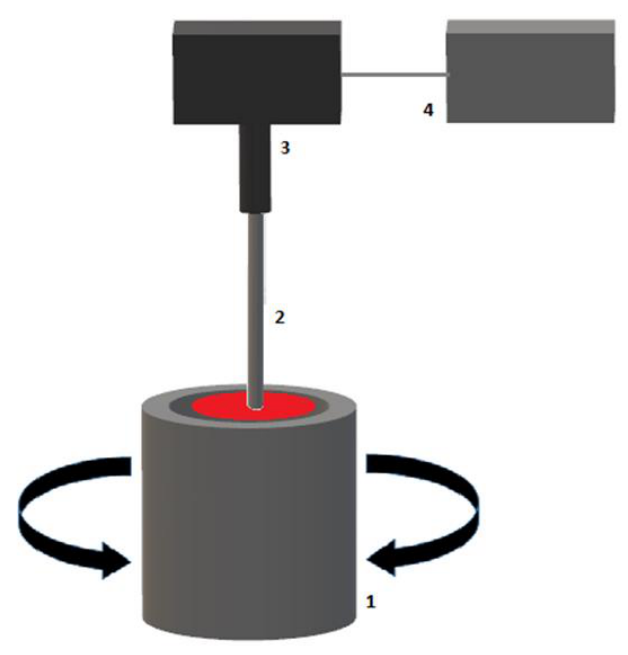
Figure 1. Schematic illustration of a TEG ® device. (1) Blood sample in rotating cup, (2) pin and torsion wire, (3) electromechanical transducer, (4) data processing unit. At the onset of each measurement, whole blood behaves as a non-Newtonian fluid, and the viscous shear between the rotating cup and stationary pin results in no torque and absent deflection in the viscoelastic